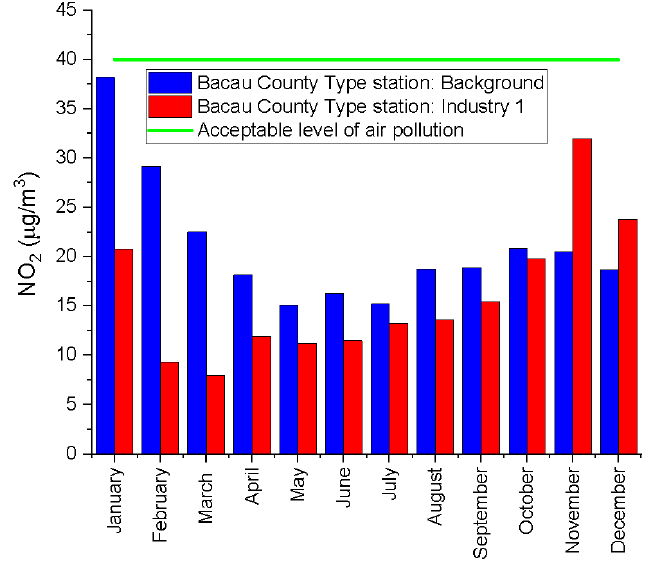
Figure 22. Average NO 2 concentration in individual months of 2020.